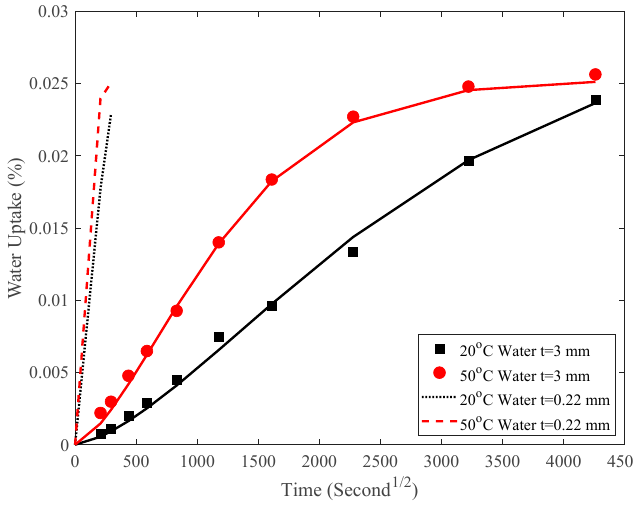
Figure 8. Water uptake of T1 adhesive.